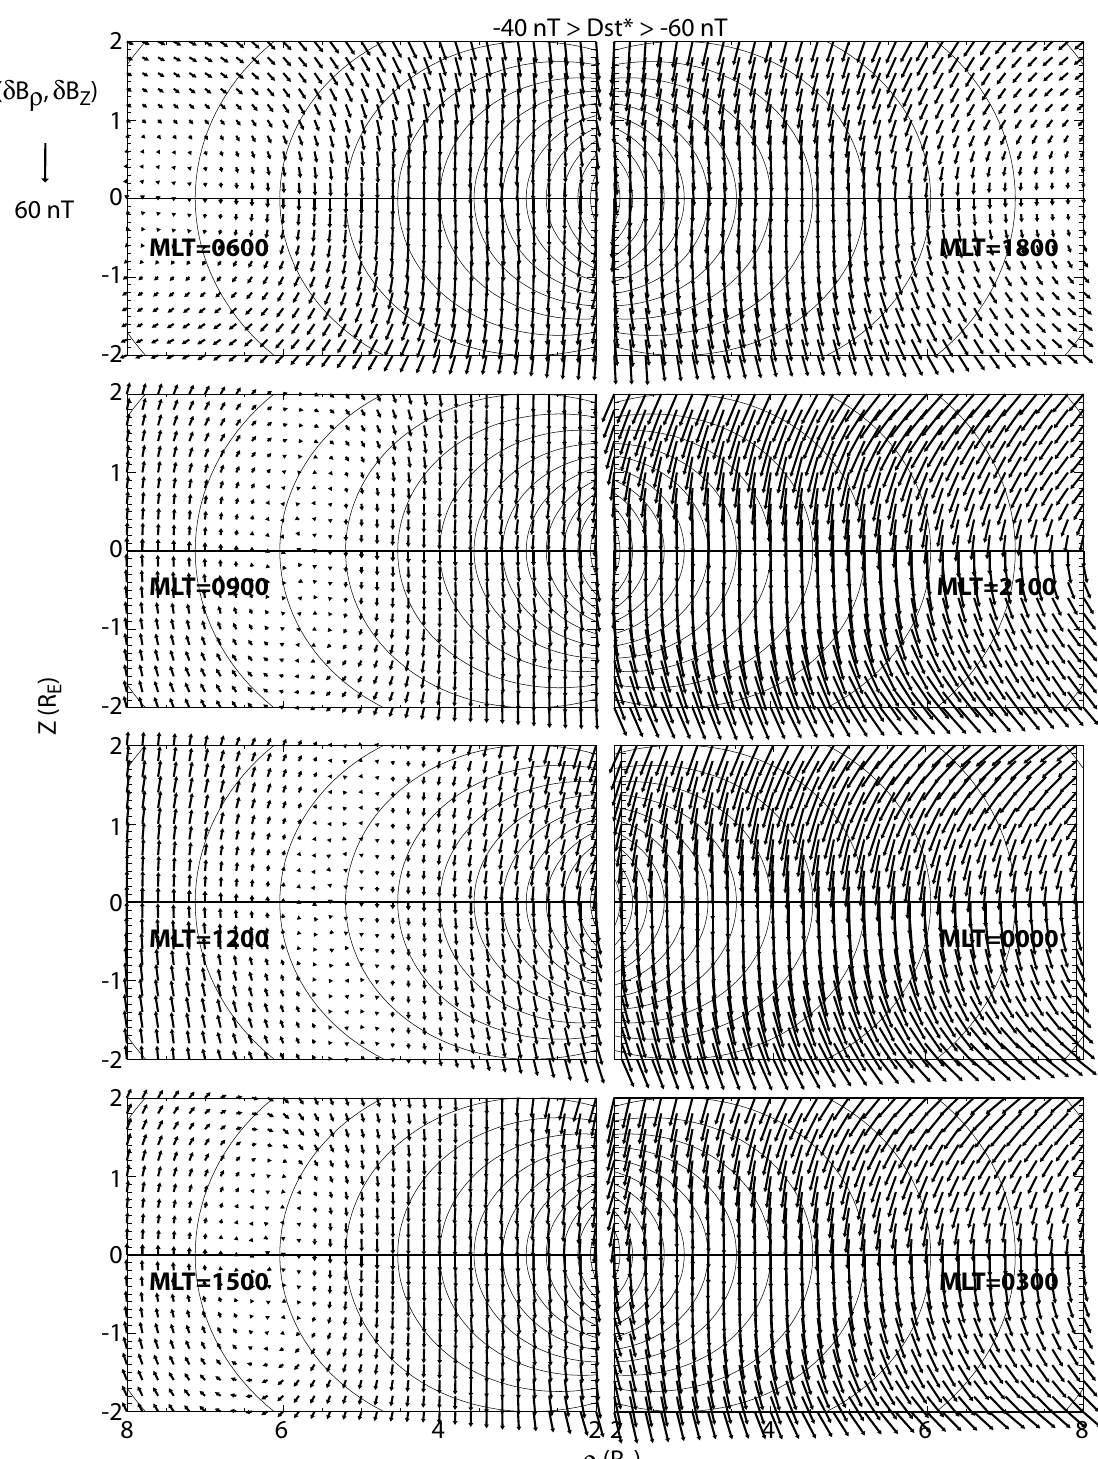
Fig. 4b. Meridional projection of the perturbation magnetic field arrows at equally spaced grids with superimposed dipole field lines in the meridian plane in each of the 8 magnetic local time bins and for each of the four D st * range: (b) − 40nT >D st * > −